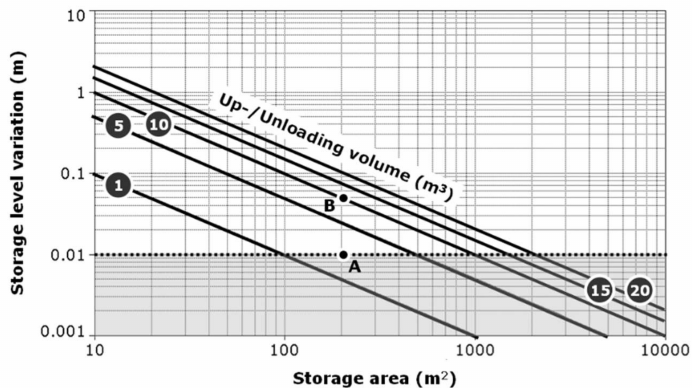
Figure 11. Sensibility of storage level variations vs. storage surface and the e ffl uent volume to be manipulated. Grey area indicates conditions that are out of the control of the monitoring system, being practically impossible to get slurry level measurement with resolutions lower than 1 cm. The two points A and B refer to a 200 m 2 -surface slurry storage located below the holed floor of the stable where 2 m 3 / day of wastes are on average produced by the herd (A) and a 10 m 3 slurry tank is used for spreading (B). Only the event B can be usefully detected being greater enough than the sensibility of the monitoring